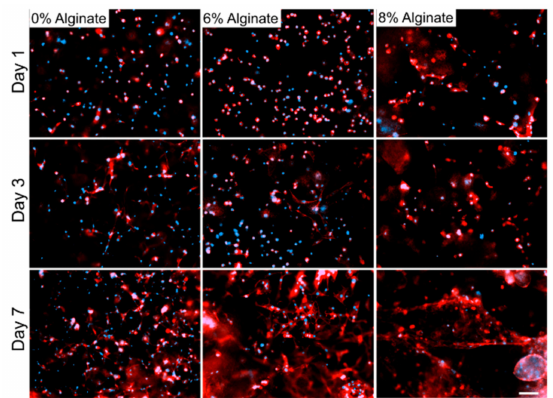
Figure 5. DAPI and F-actin staining of C2C12 in GelMA hydrogel with alginate concentrations 6% and 8% (w / v) crosslinked with UV and CaCl 2 . Images were taken on days 1, 3, and 7. Blue color represents the cell nucleus and red color represents the cell cytoskeletal by the F-actin microfilaments. Scale bar denotes 200 µ